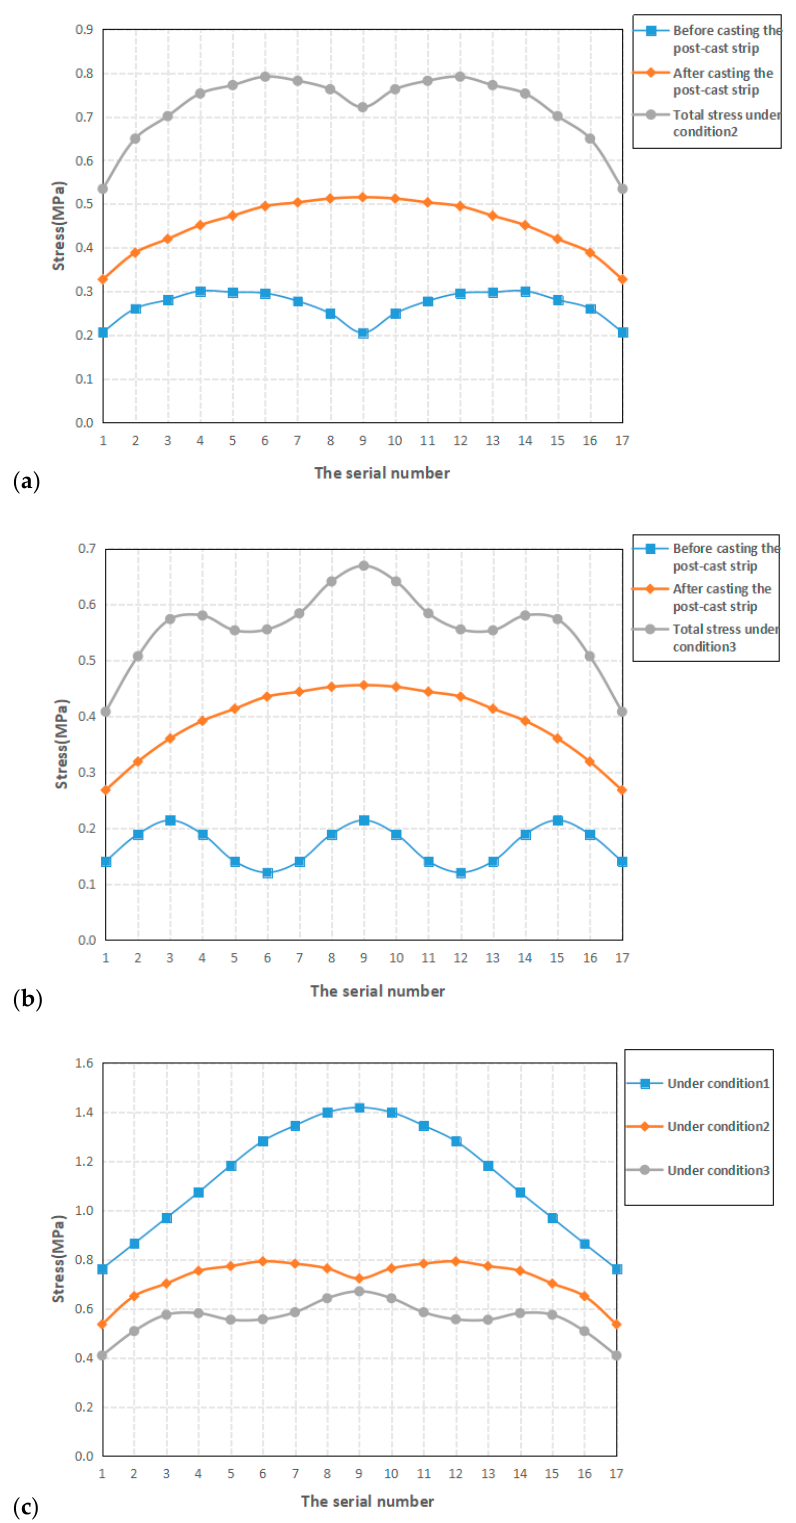
Figure 6. Stress profiles under three working conditions: ( a ) Condition 2; ( b ) Condition 3; ( c ) Conditions 1, 2 and 3.